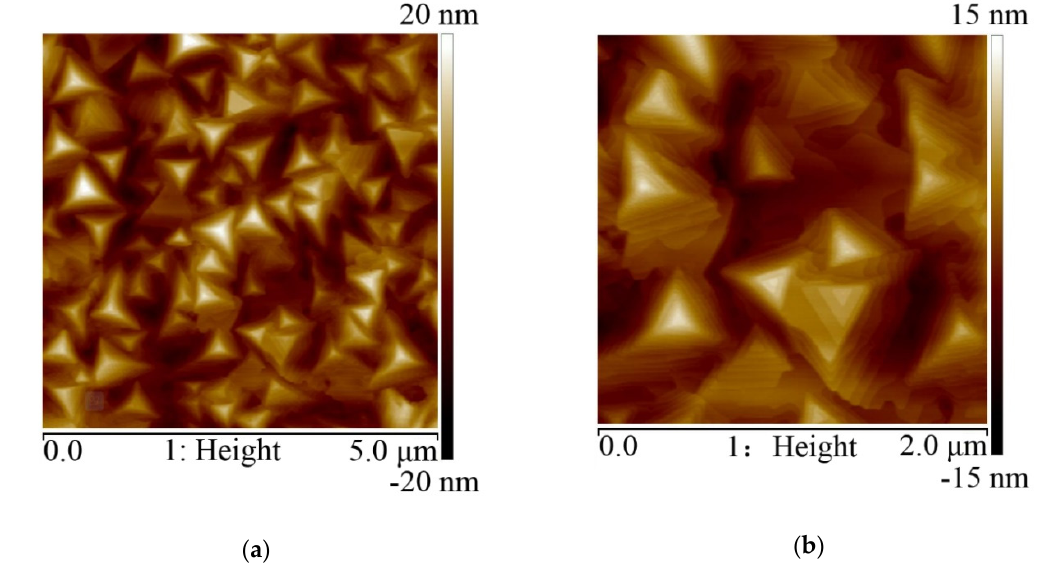
Figure 5. AFM images of Bi 2 Se 3 on mica with an amorphous buffer layer. ( a ) is on a 5 × 5 μ m 2 scale; ( b ) is on a 2 × 2 μ m 2 scale.